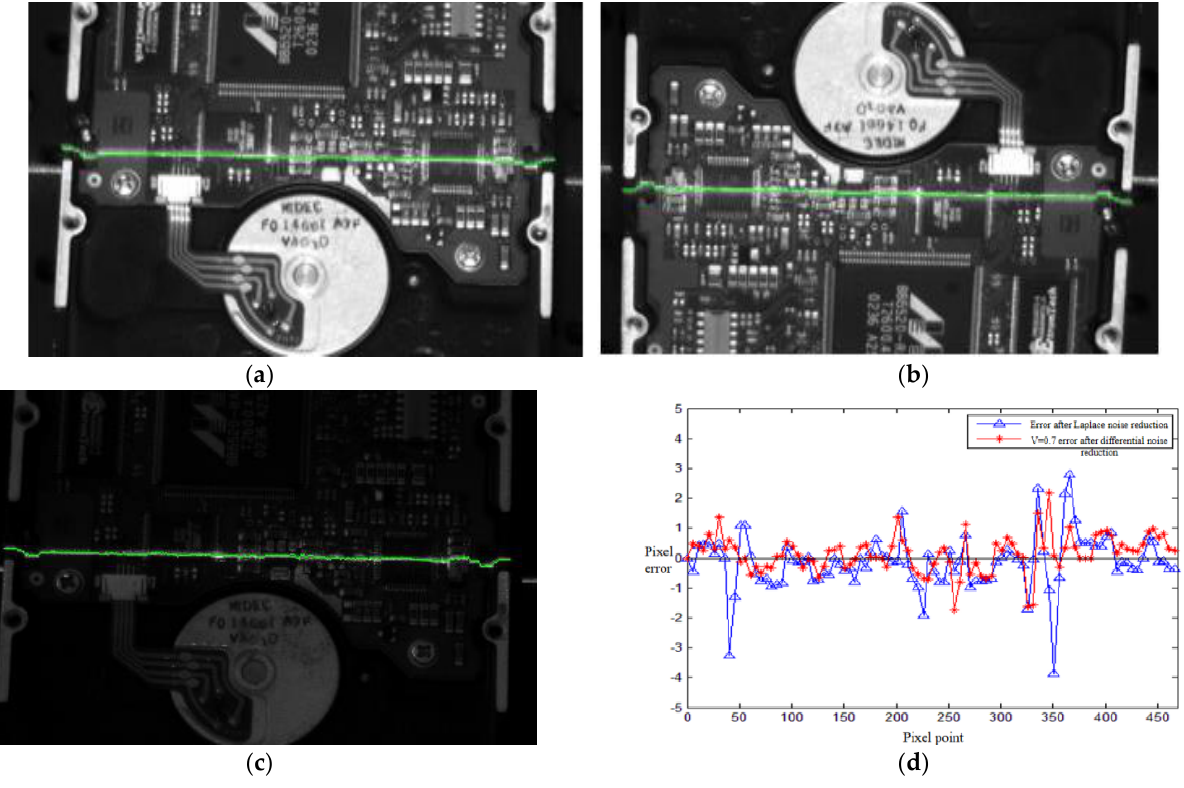
Figure 11. PCB strip center extraction and performance comparison: ( a ) extracting the light stripe center after the Steger method; ( b ) v = 0.7 order differential enhancement extracting the stripe center; ( c ) dark background dark light bar image extraction of the light bar center; ( d ) performance comparison. After the strong reflection area was enhanced by fractional differentiation, the image outline was clearer, as shown in Figure